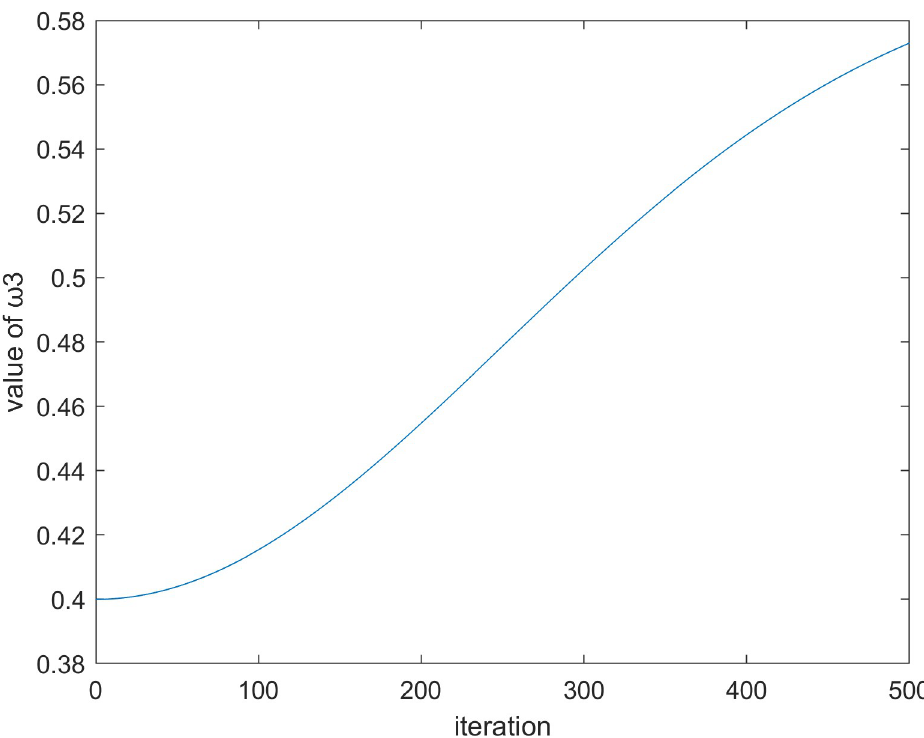
Fig 4. The iteration diagram of ω t